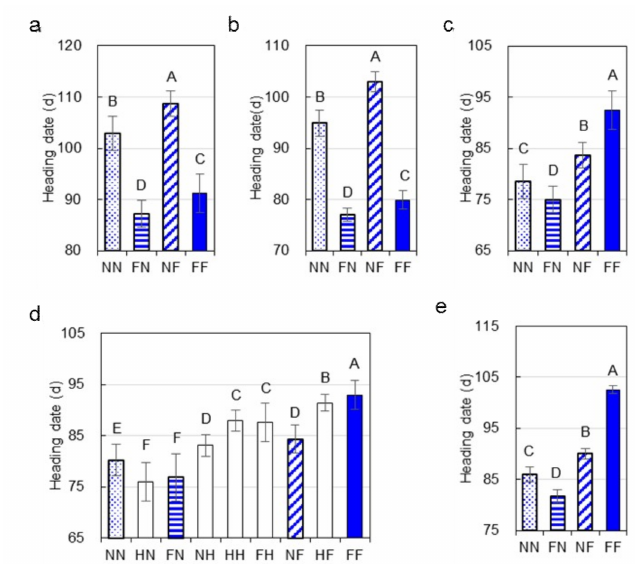
Figure 2. Heading date of rice lines classified based on the genotype of Hd1 and Ghd7 . ( a ) R1-NIL population under the NSD conditions in the 16LS trial. ( b ) R1-NIL population under the NSD conditions in the 17LS trial. ( c ) R1-NIL population under the NLD conditions the 17HZ trial. ( d ) R2-F 2 population under the NLD conditions in the 17HZ trial. ( e ) R2-NIL population under the NLD conditions in the 18HZ trial. NN, hd1 MY46 ghd7 ZS97 ; HN, Hd1 heterozygous ghd7 ZS97 ; FN, Hd1 ZS97 ghd7 ZS97 ; NH, hd1 MY46 Ghd7 heterozygous ; HH, Hd1 heterozygous Ghd7 heterozygous ; FH, Hd1 ZS97 Ghd7 heterozygous ; NF, hd1 MY46 Ghd7 MY46 ; HF, Hd1 heterozygous Ghd7 MY46 ; FF, Hd1 ZS97 Ghd7 MY46 . Data are presented in mean ± sd. Bars with different letters are significantly different at p < 0.01 based on Duncan’s multiple range tests.